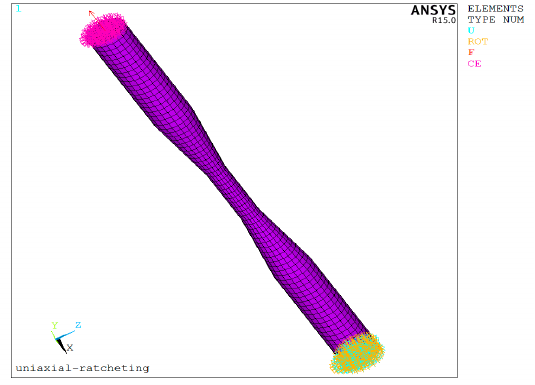
Figure 17. Boundary conditions applied to the specimen finite element model.